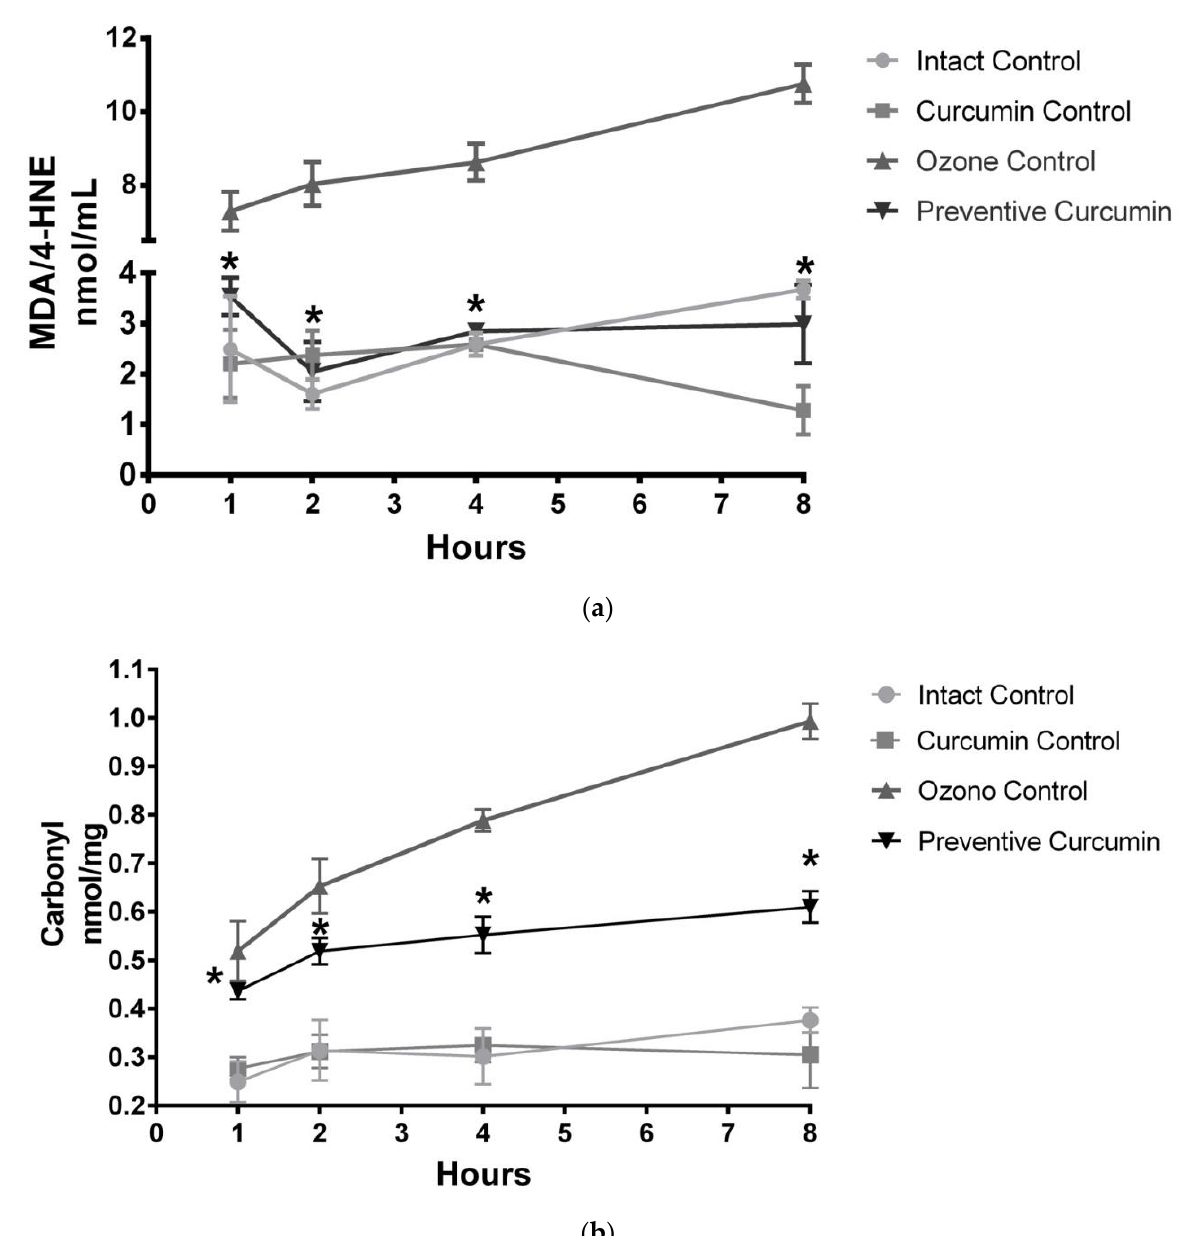
Figure 5. Antioxidant effect of CUR on lipid and protein damage by short-term exposure to O 3 (Table S5A and S5B). ( a ) Plasma concentration of MDA/4-HNE (nmol/mL) for each experimental group ( n = 5). ( b ) Plasma concentration of carbonylated proteins (nmol/mg) in the experimental groups ( n = 5). Data represent the mean value ± SEM, and the asterisk indicates a statistical difference between the preventive curcumin and ozone control groups at all testing times for MDA/4-HNE concentration ( p < 0.001) and protein carbonylation ( p < 0.001).